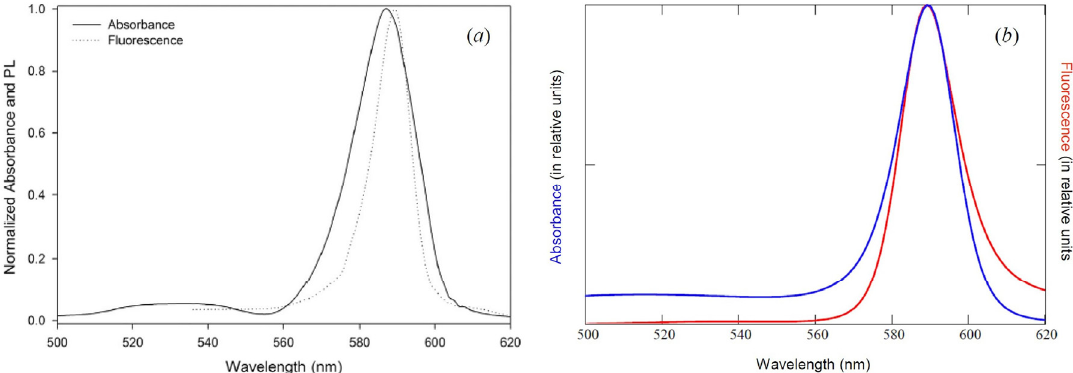
Figure 9. Comparison of theory with experiment for J-aggregates in Langmuir films. ( a ) Absorption and fluorescence J-bands of a C18S4 monolayer obtained in a Langmuir film [86]. The characteristics of photoluminescence (PL) spectrum: a peak at 590 nm, a FWHM = 18 nm and a Stokes shift of 1 nm [86]. ( b ) Theoretical absorption and fluorescence J-bands [6], fitted to the experimental data [86] (see ( a )). The absorption J-band is computed from Equations (7)–(27), where the “J-aggregate + environment” system parameters are m = m e ( m e is the electron mass); n ref = 1.33; ω = 5 × 10 13 s − 1 ; J 1 = 4 eV; J 1 − J 2 = 1.19 eV; L = ( 6 + 2 ) d (2 d lengthening the optical chromophore shown in Figure 10 due to the J-aggregation [6,7,22–26,40] (see Figure 5), d = 0.14 nm [7,8,22–26,40,75], L J (Enr) = (6 + 2) 0.14 nm = 1.12 nm), then we obtain E = 0.349 from the Egorov nano-resonance (4) (in Equation (12) parameter θ = 1/2); γ = 0.092 eV; and T = 298 K. The fluorescence J-band is symmetric to the absorption J-band and obtained from the latter by changing the sign in the heat energy ∆ and increasing the energy gap J 1 − J 2 = 1.19 eV by 0.785 eV in order for the Stokes shift to be zero (cf. Figure 8).